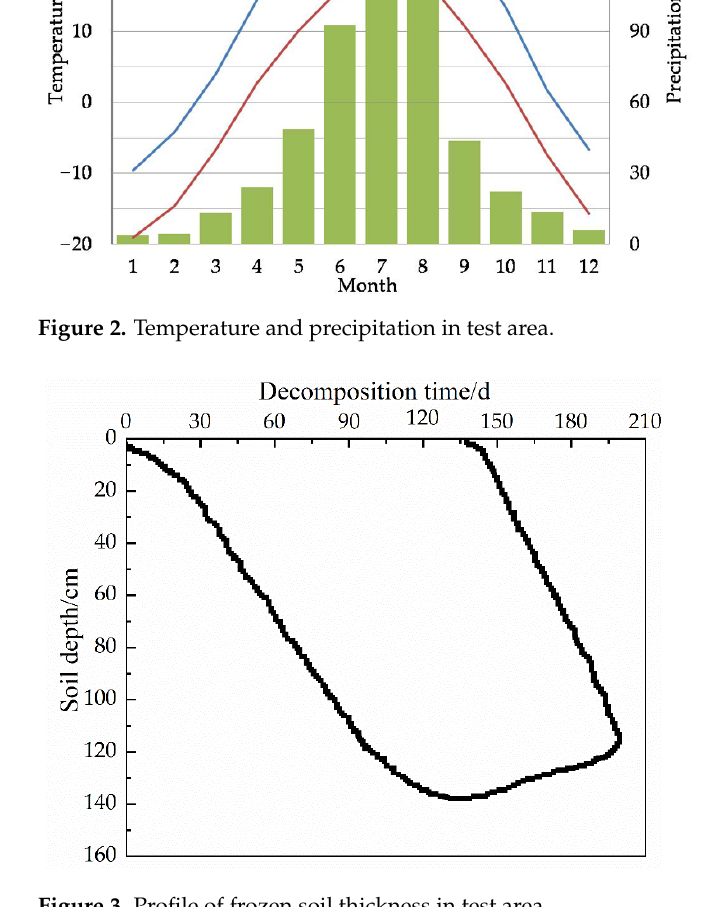
Figure 3. Profile of frozen soil thickness in test area.